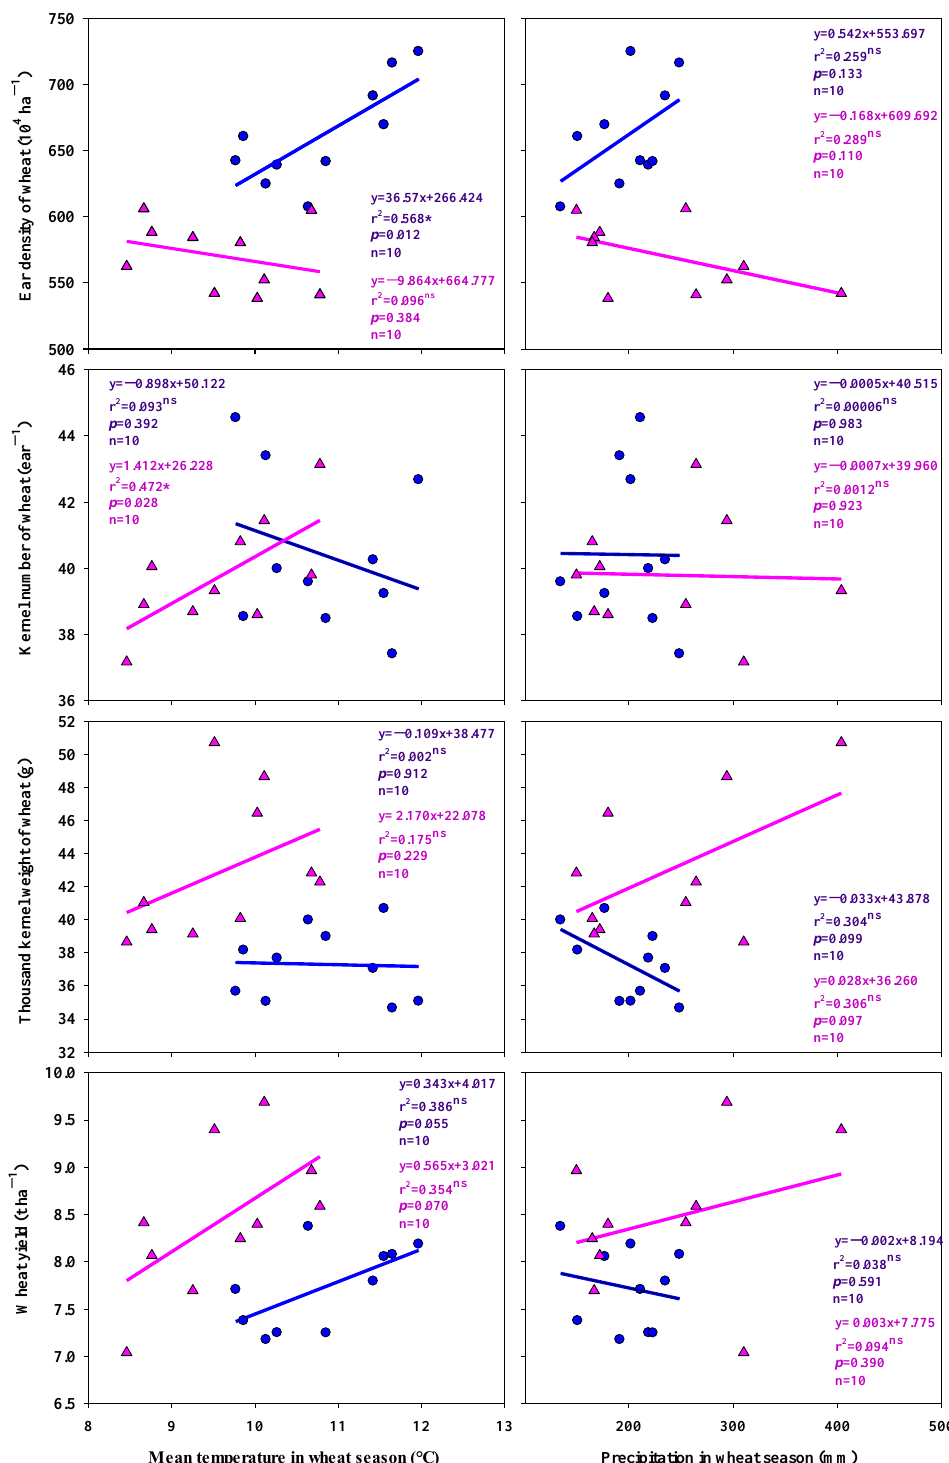
Figure 9. Correlation between wheat yield, yield components and mean temperature and precipitation in the wheat season. The blue circles, lines, and formulas represent the data of the Tai’an experimental site, and the pink circles and lines represent the data of the Longkou experimental site. r: correlation coefficient; p : significance level; n: sample size; *: Significant at p < 0.05 . ns : not significant.